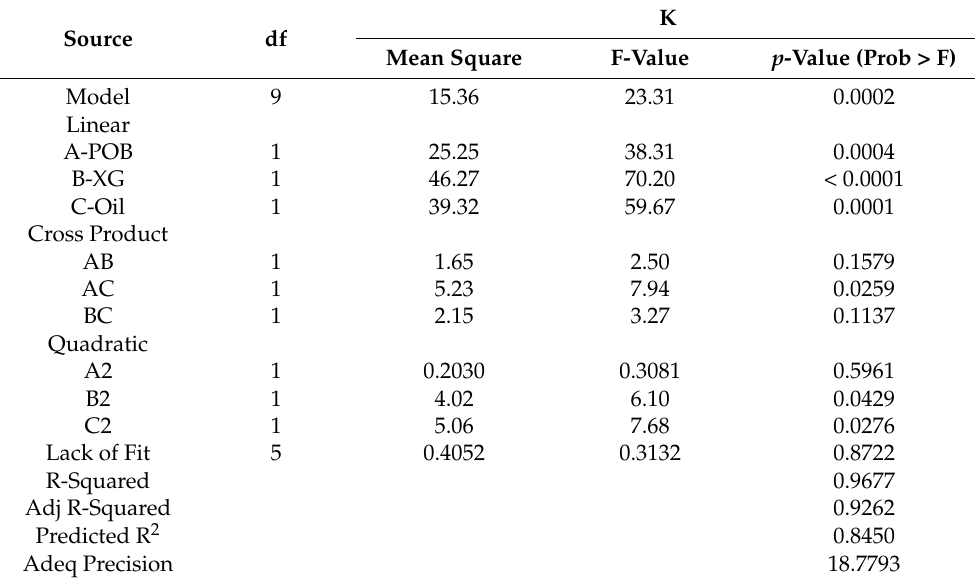
Table 4. The significance of the regression models established (F and p value) as a result of RSM. Source